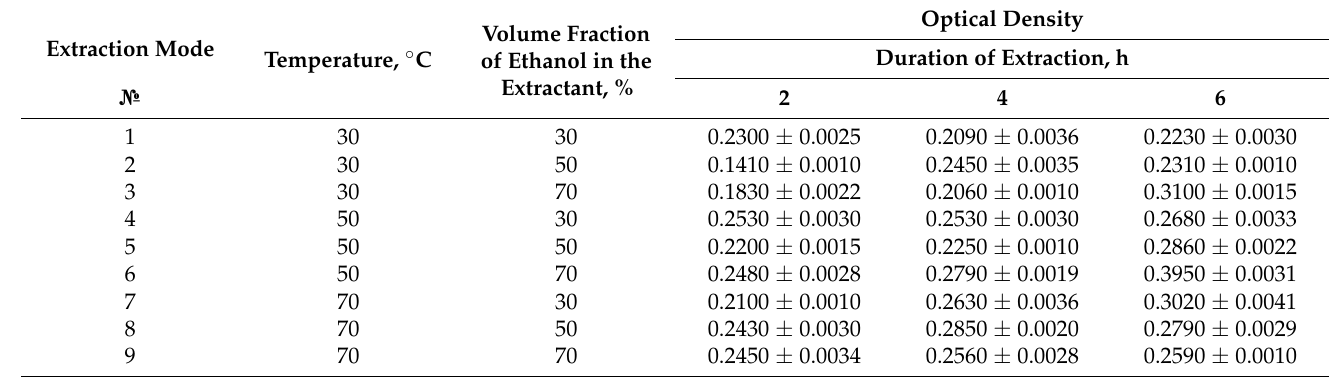
Table 1. Optical density of extracts of Ginkgo biloba callus